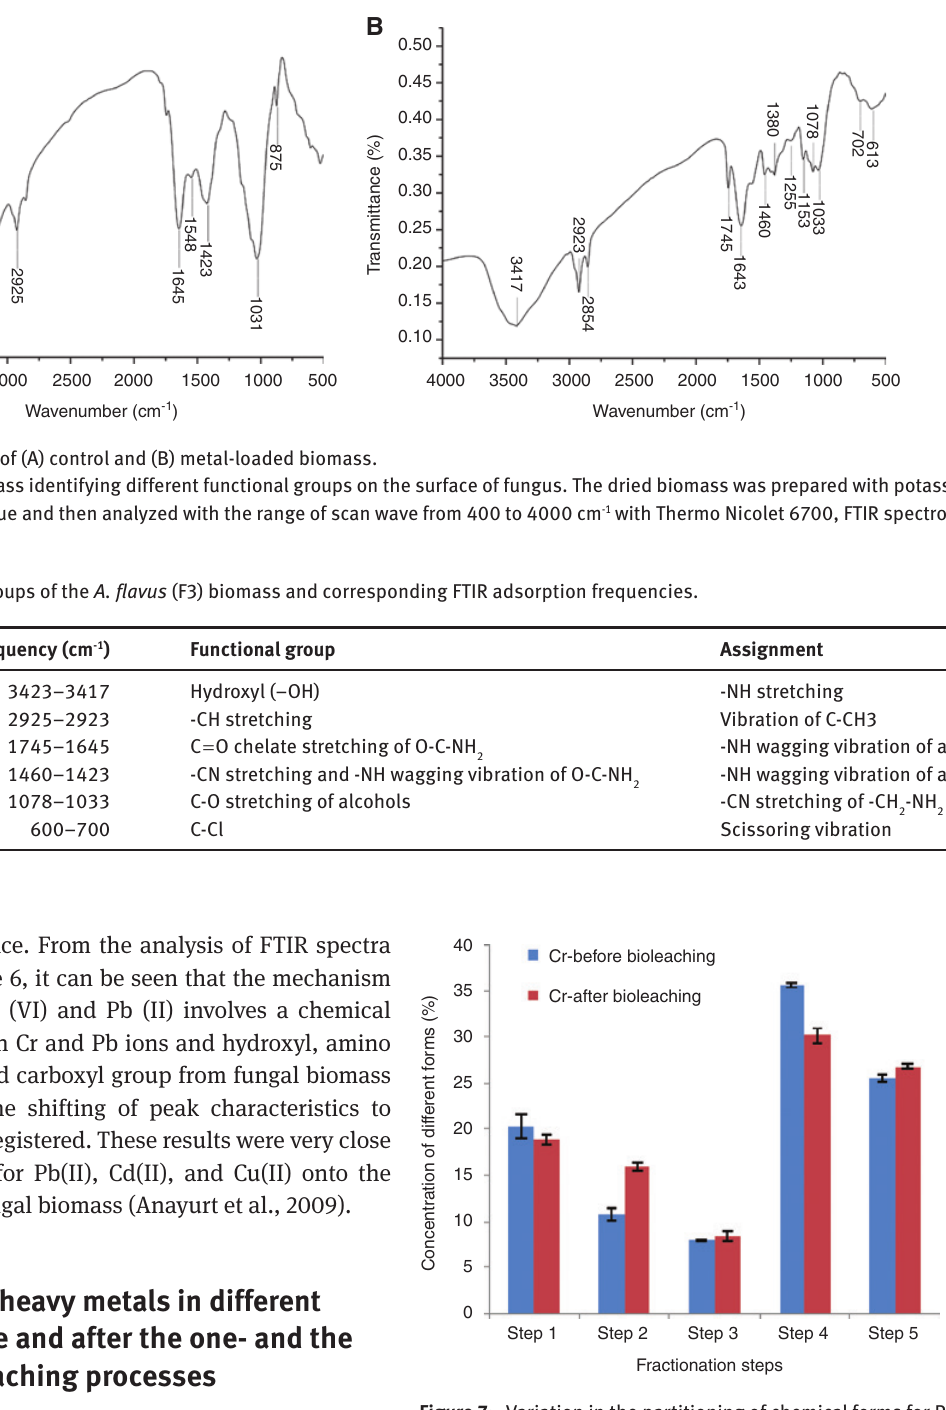
Figure 7: Variation in the partitioning of chemical forms for Pb (II) before and after the one-step bioleaching process.